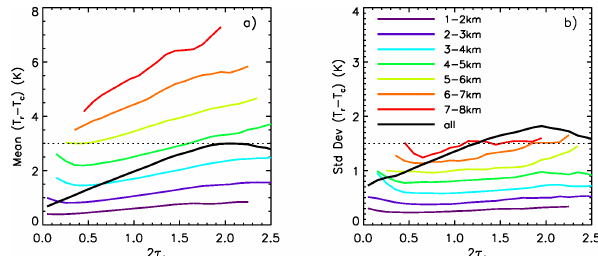
Figure 3. (a) Mean value and (b) standard deviation of the differ- ence T r – T c between cloud radiative temperature and temperature at centroid altitude of attenuated total backscatter against 2 τ a assum- ing r = τ vis / τ a = 2. Colored lines are for several ranges in cloud geometric thickness. The black line is for all samples. The hori- zontal dotted lines indicate maximum values discussed in the text. fidence, base temperature < − 20 ◦ C, over ocean, 2008.